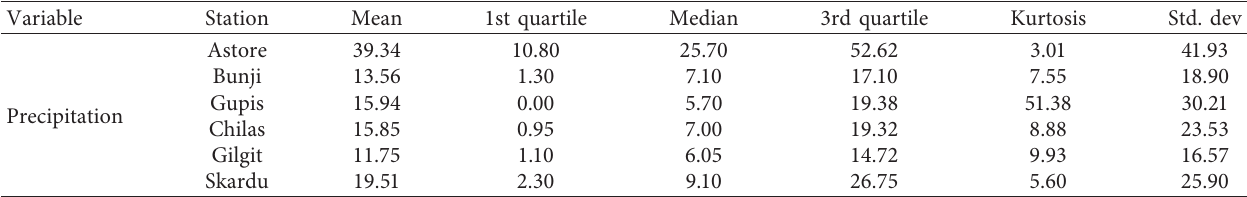
Table 1: The precipitation characteristics during the period 1971–2017 of six selected stations. Variable